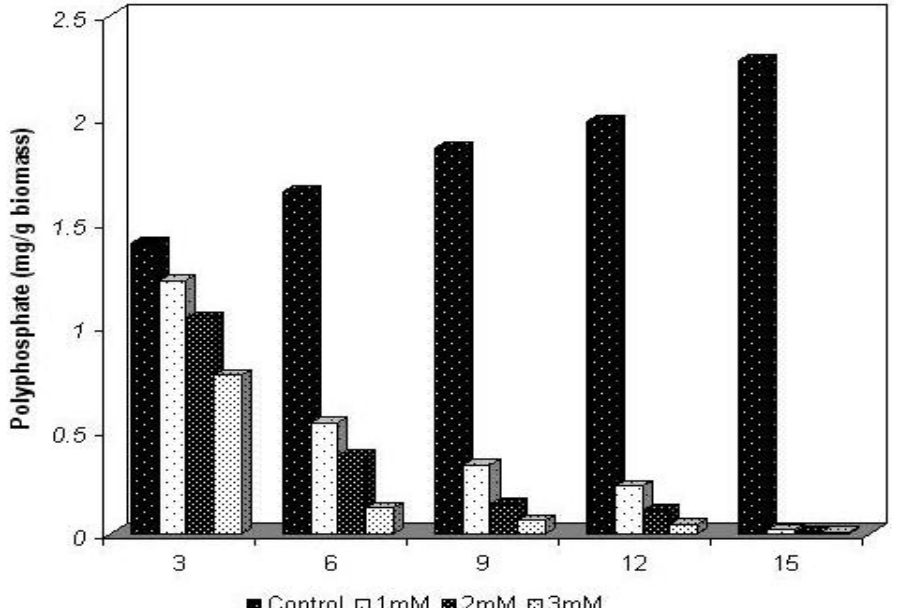
Figure 5. The physiological behavior of Trichoderma harzianum polyphosphate, cultivated in the absence and presence of